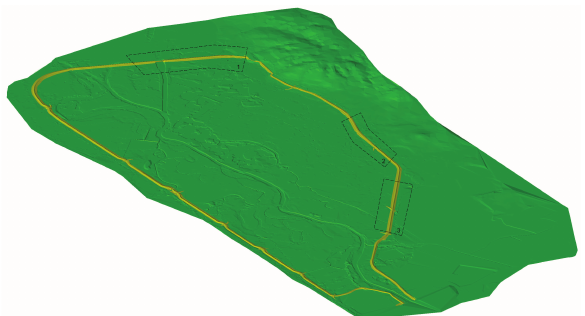
Figure 2: View of the triangle mesh of the terrain model of the reservoir’s area, with locations of numerical models